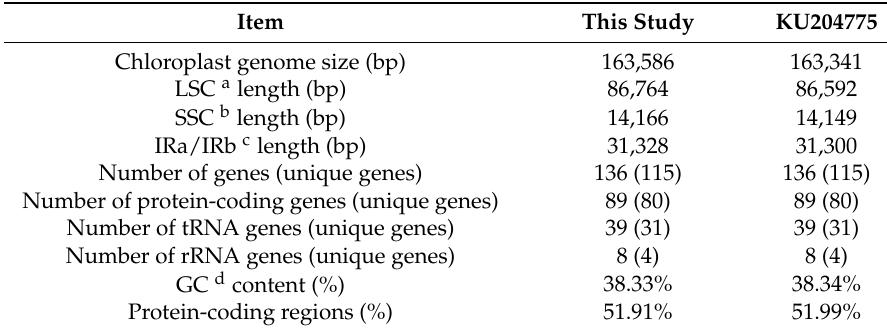
Comparison between the newly and previously sequenced chloroplast genomes of Eucommia ulmoides .